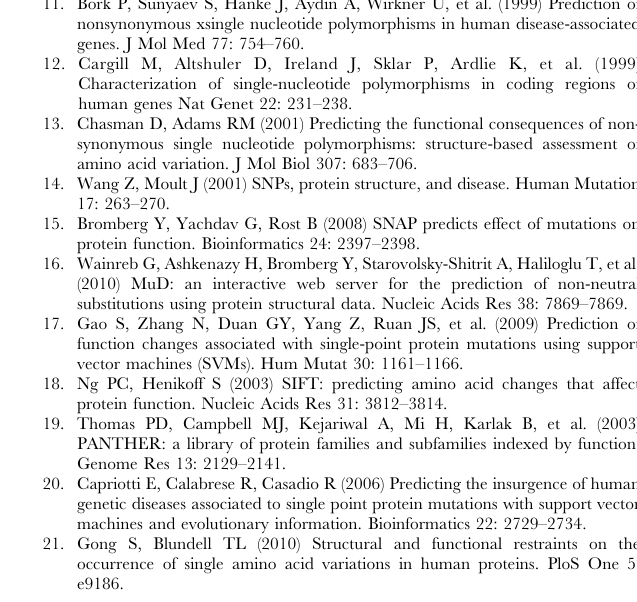
Table S2 The mean values and standard deviations of the 15 final selected optimal features for the disease- associated and neutral SAVs. Mean: mean value; SD: standard deviation. P-value was calculated using the unpaired two-sample t -test. Table S3 The prediction performance of RF-based classifiers based on different feature group combina- tions according to the MDGI Z-Score. Table S4 The importance and contributeon of the 15 final optimal features by removal or inclusion of this feature to the first-stage RF classifier. Table S5 Performance of the first-stage and two-stage classifiers based on an independent test dataset. Table S6 Analysis of several important final features that are related to the residue locations in three exemplar proteins in the case